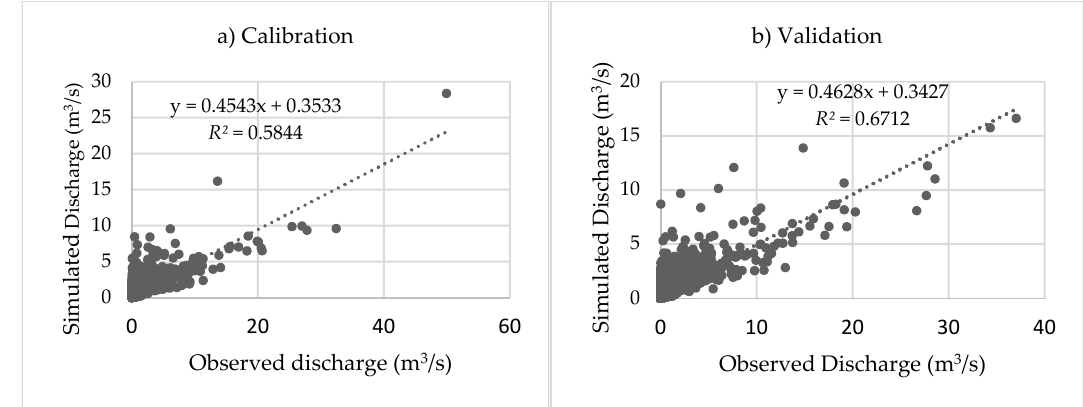
Figure 9. Correlation between observed and simulated daily river discharge for Njoro River at 2FC05 station for the calibration period (1984 ‒ 1996) and the validation period (1997 ‒ 2007). Table 6. Model performance assessment based on daily river discharge, as guided by Moriasi et al. [52].